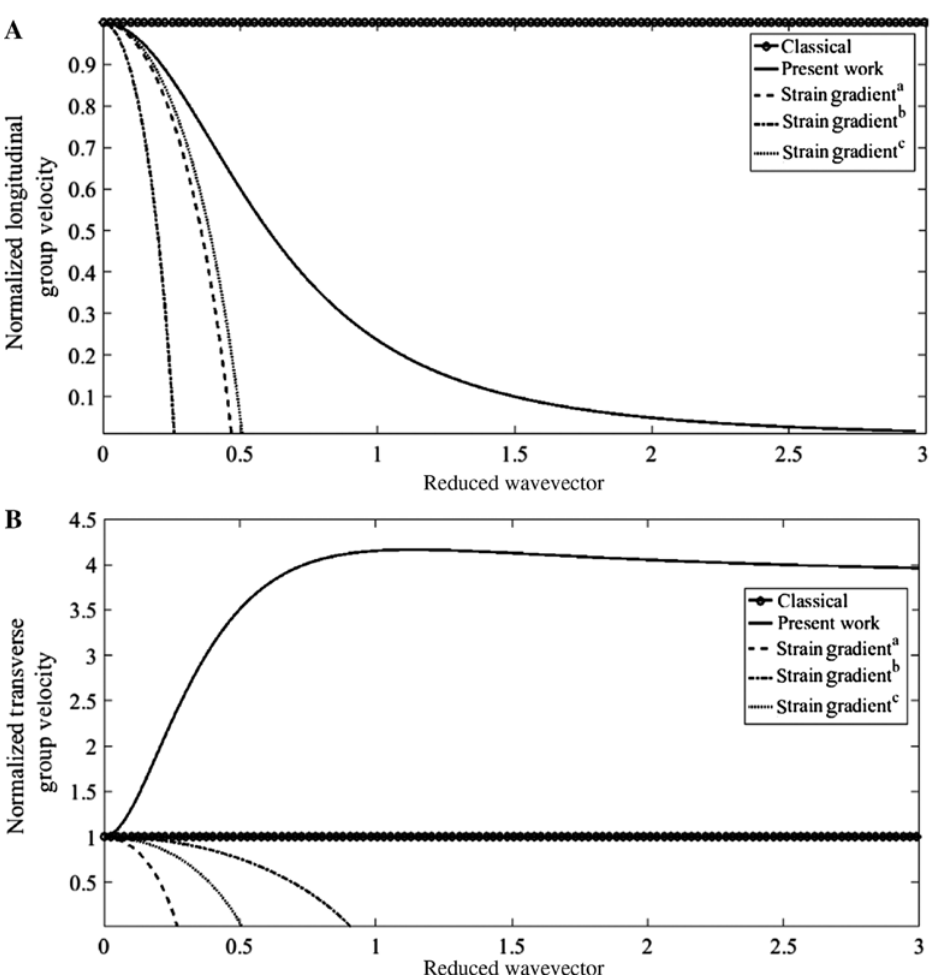
Figure 3: The normalized longitudinal group velocity (A), and the normalized transverse group velocity, (B), of Si. a, b, and c curves were plotted according to the SGT and predicted mechanical constants in [8], [36], and [3],